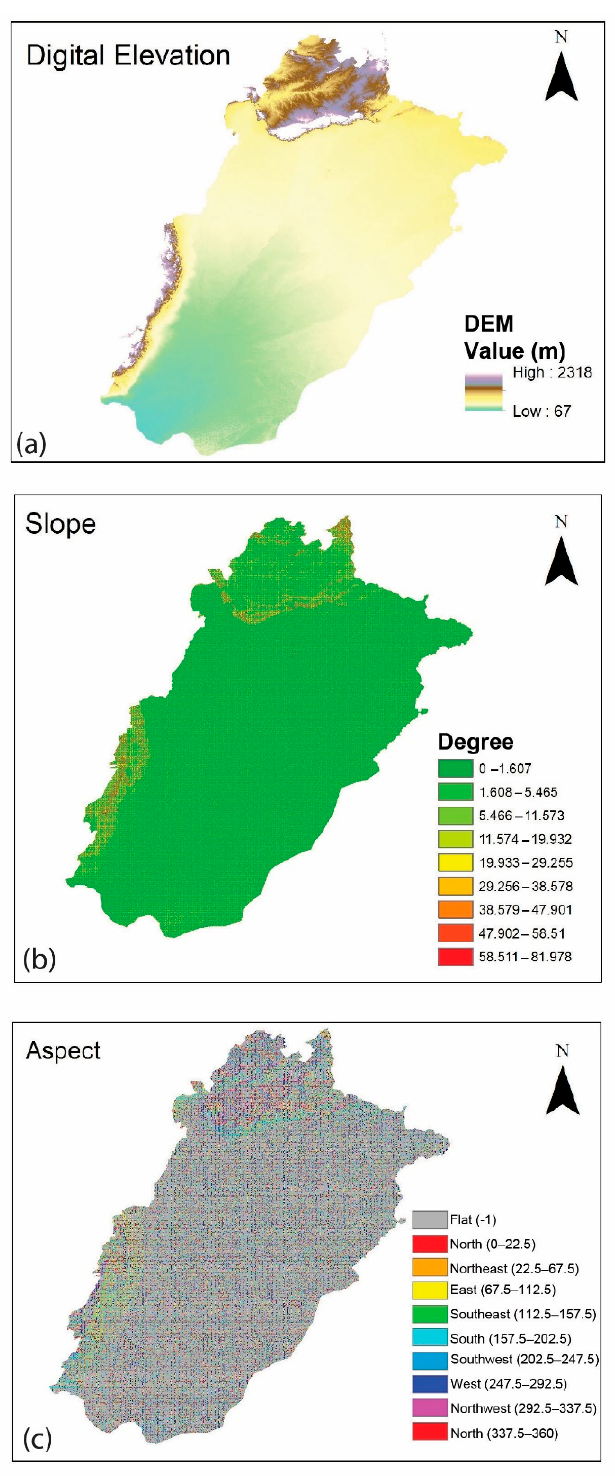
Figure A3. Maps of indicators belonging to land resources group (G3): ( a ) normalized difference vegetation index; ( b ) dominant landcover classes.